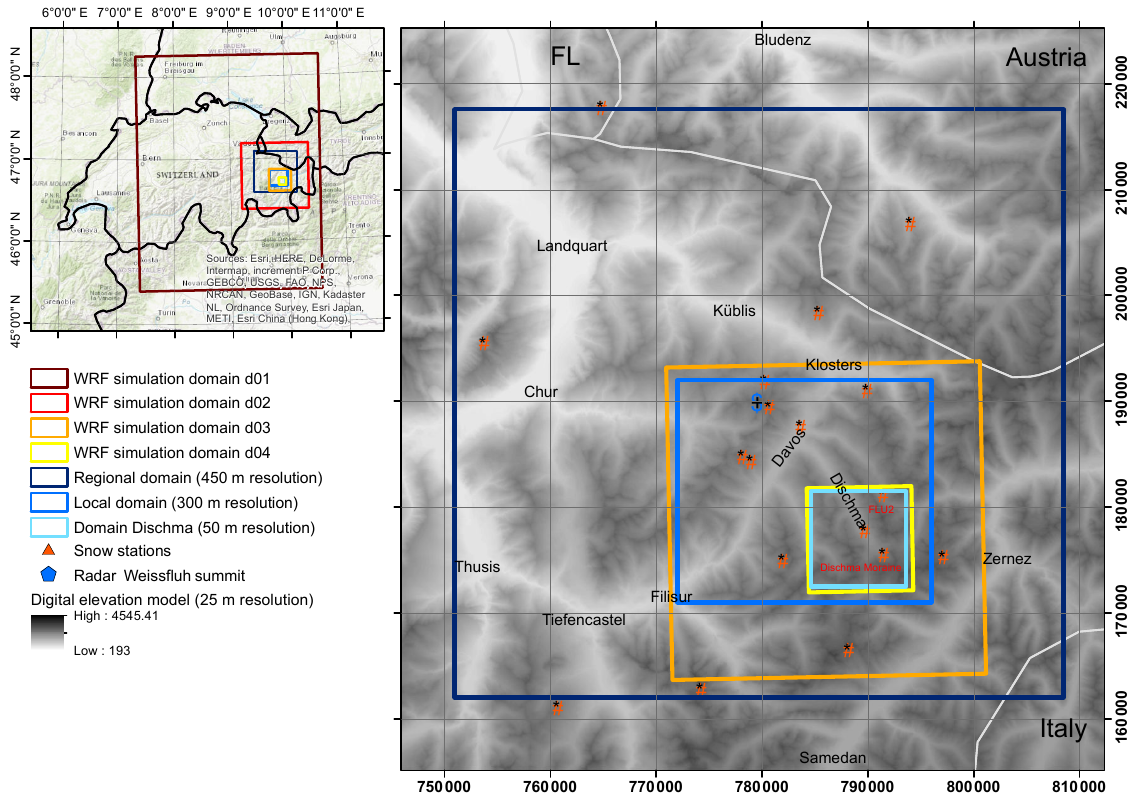
Figure 1. Overview over the study area in the eastern part of Switzerland surrounding Davos. WRF simulation domains (d01–d04, dark red to yellow) and evaluation domains (blue) give information on the simulation and evaluation setup. The 18 meteorological stations (red triangles) are within or very close to the regional domain. The two stations Dischma Moraine and FLU2, which are used to validate the model, are within the domain Dischma. The operational weather radar is located on the Weissfluh summit at approximately 2830m above sea level (ma.s.l., blue pentagon). Coordinates in the right panel are in Swiss coordinates CH1903LV03 (unit: m). Shaded topography: dhm25 ©2018 swisstopo